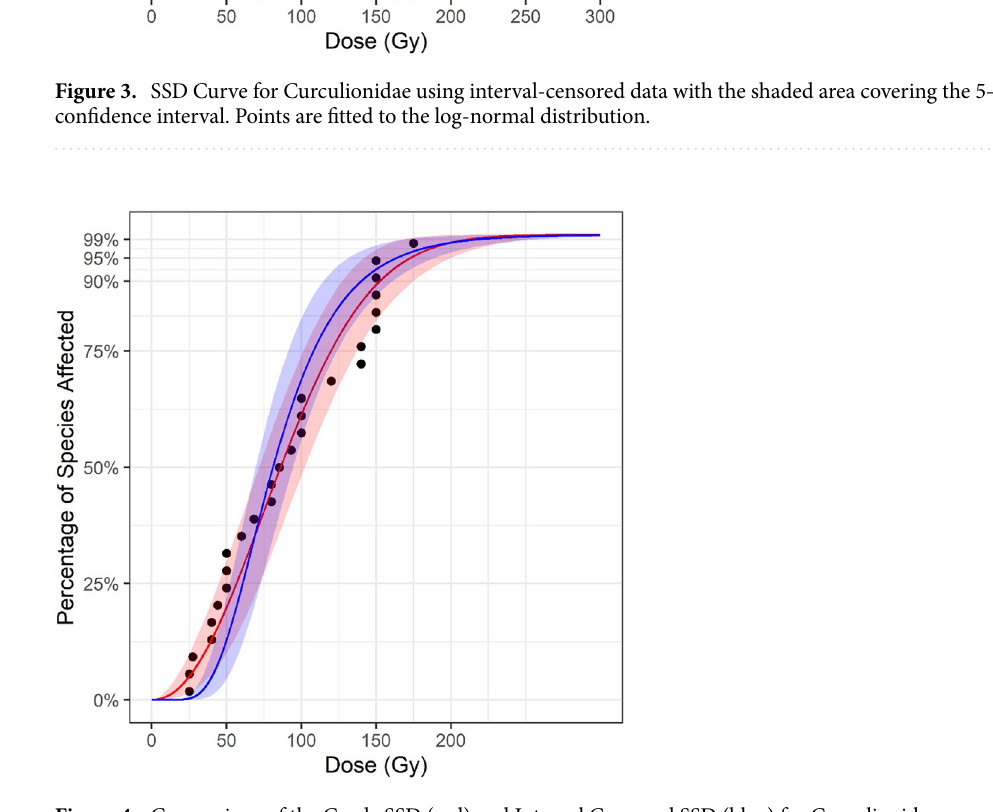
Figure 4. Comparison of the Crude SSD (red) and Interval Censored SSD (blue) for